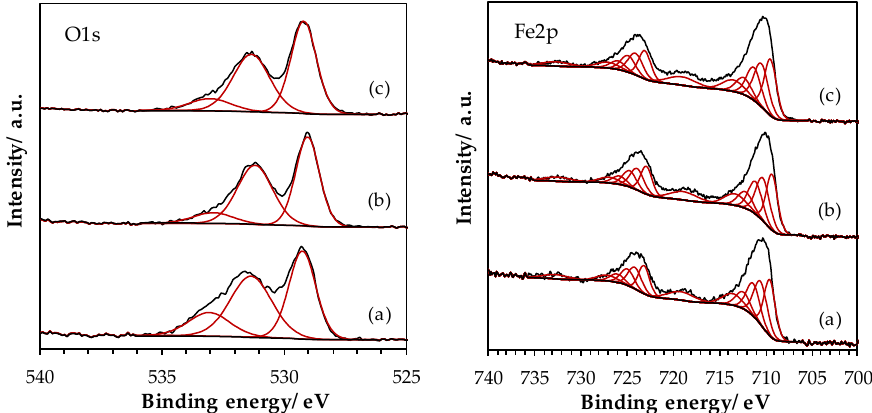
Figure 6. High-resolution spectra of O 1s and Fe 2p core level spectra for LaFeO 3 samples: (a) SSR, solid state reaction; (b) HEBM, high energy ball milling; (c) LEBM, low energy ball milling.